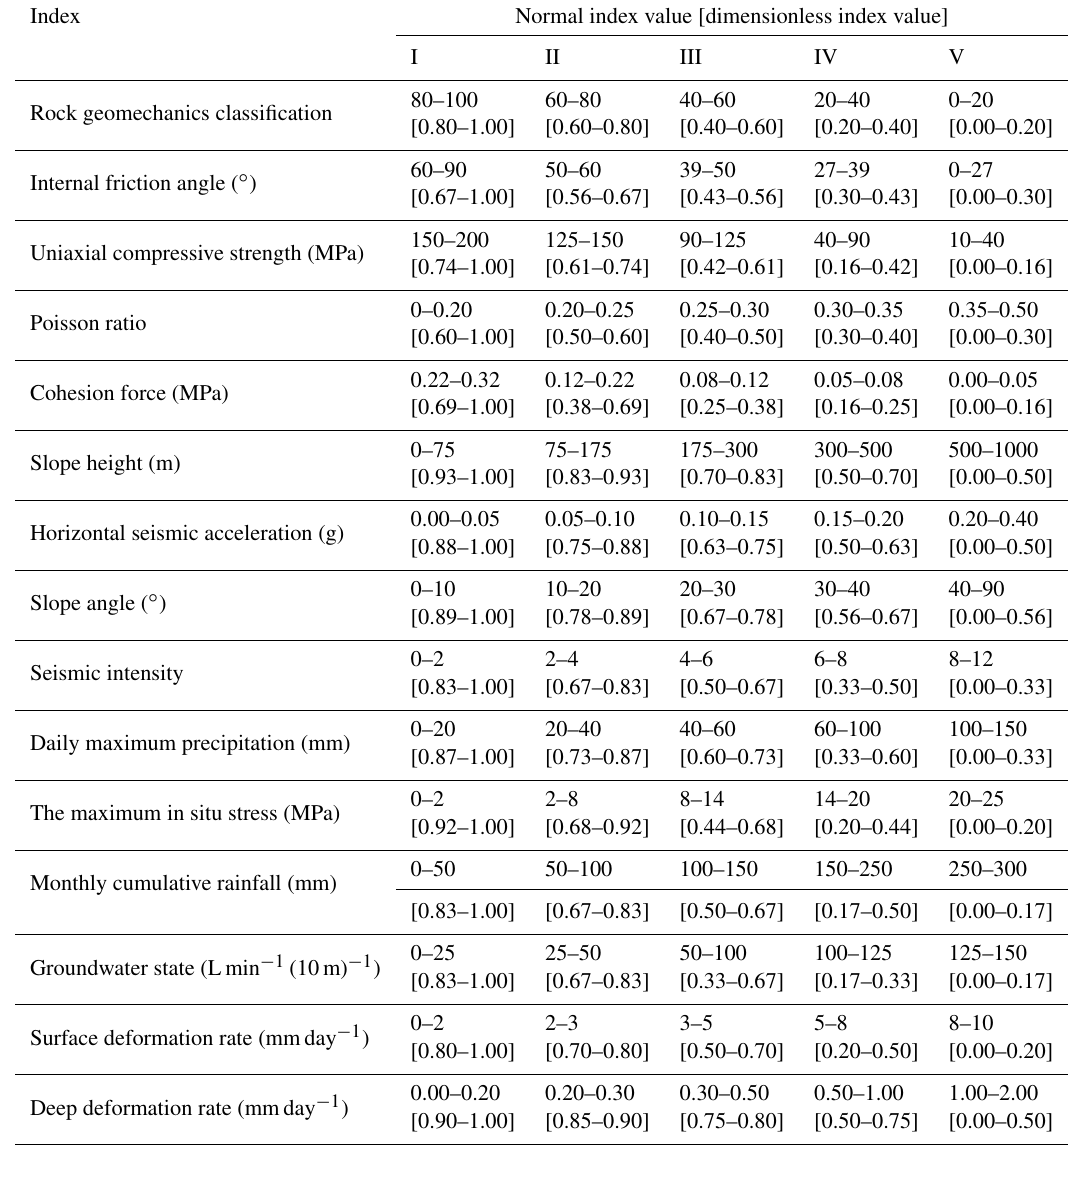
Table 1. Value rank of evaluation index under different